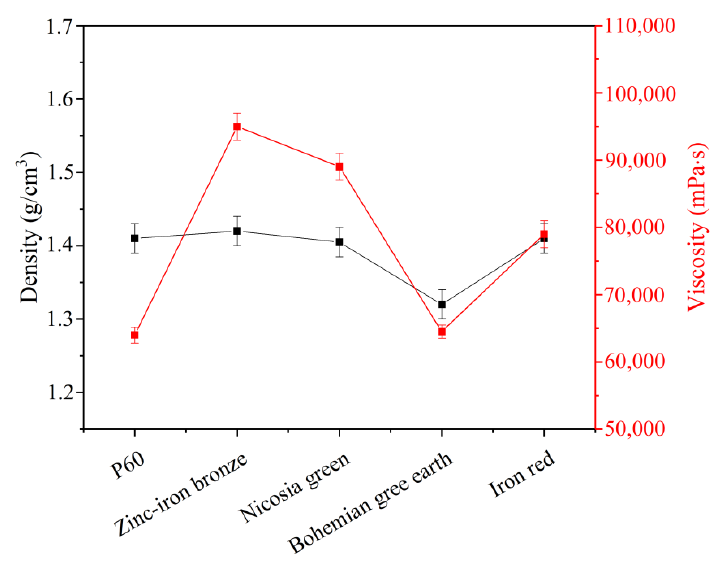
Figure 1. Effects of pigments on paint density and viscosity.